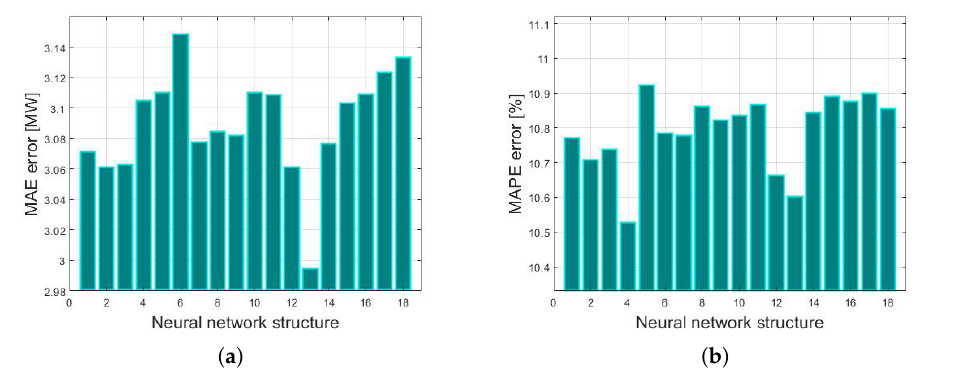
Figure 21. Summary of forecast accuracies by the selected neural network structure for wind power plant FW2. ( a ) MAE. ( b ) MAPE.